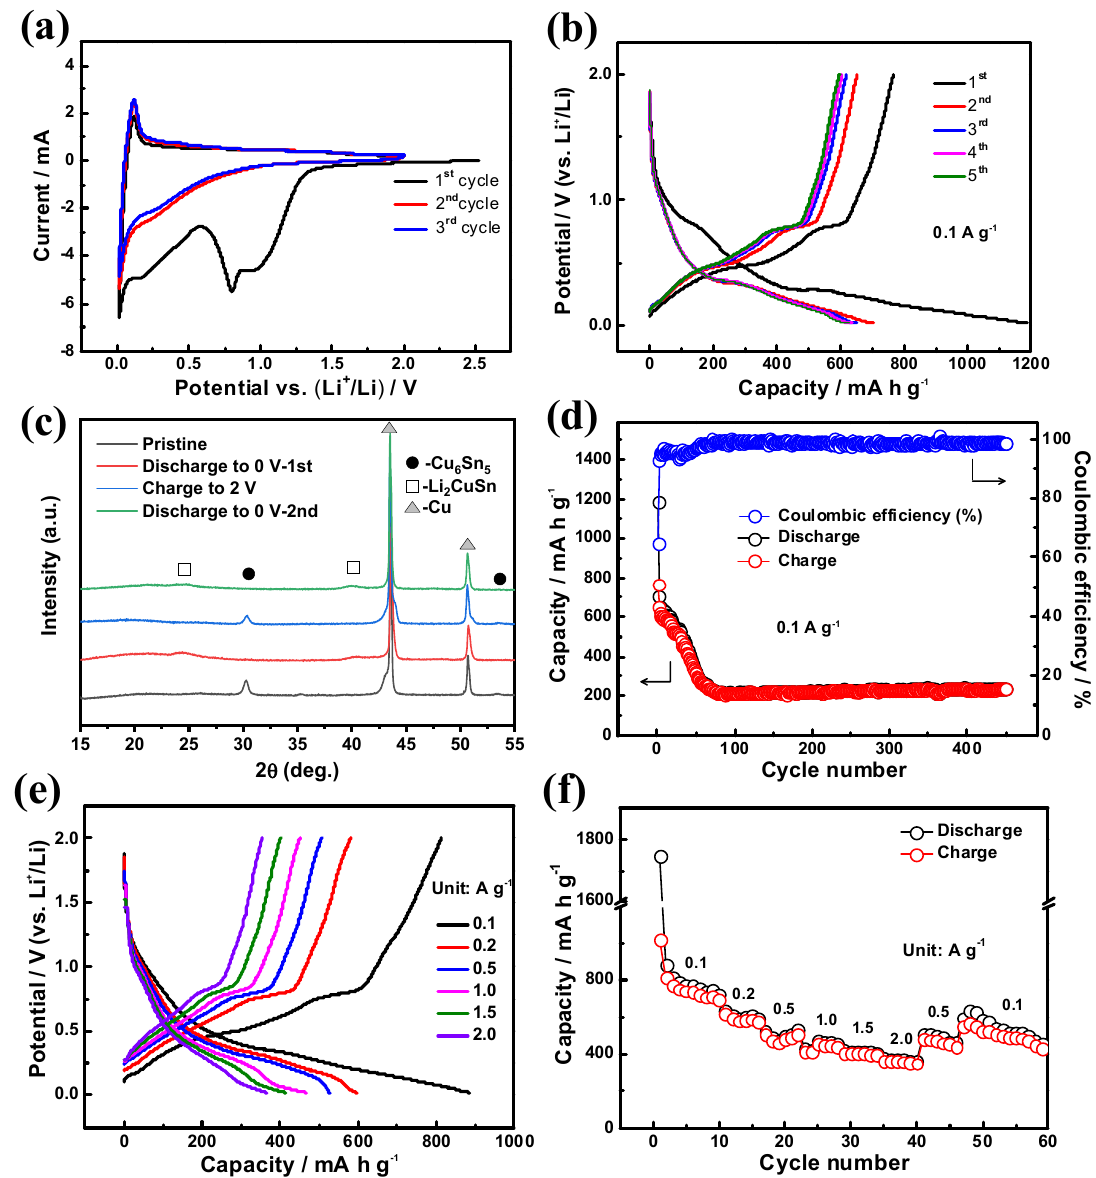
Figure 5. ( a ) CVs at a scan rate of 0.1 mV s − 1 between 0.01 and 2.5 V (vs. Li + /Li). ( b ) The initial five charge/discharge profiles of as-dealloyed Cu 6 Sn 5 anode with the current density of 0.1 A g − 1 . ( c ) Ex situ XRD patterns collected at various states. ( d ) Cycling performance of the Cu 6 Sn 5 at current density of 0.1 A g − 1 . ( e ) The charge–discharge voltage profiles of the Cu 6 Sn 5 alloy electrode at various current densities from 0. 1 A g − 1 to 2.0 A g − 1 . ( f ) Rate performance at various current densities from 0. 1 A g − 1 to 2.0 A g − 1